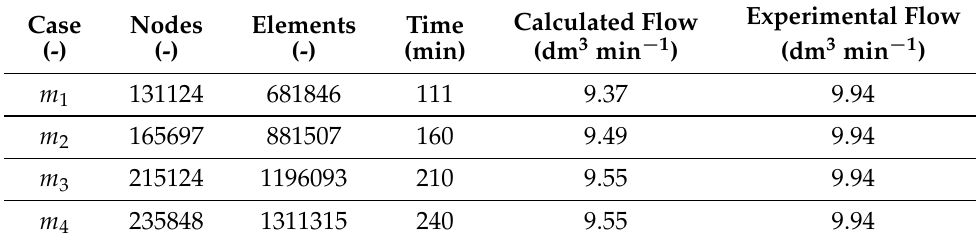
Table 1. Mesh quality assessment.